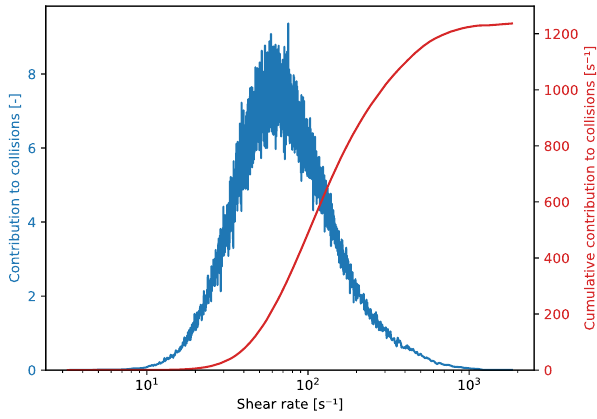
Figure 10. Contribution of shear rates to collision